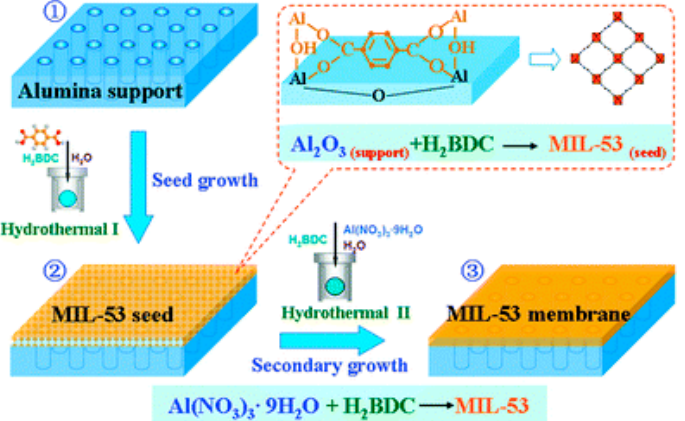
Figure 9. Schematic diagram of preparing the MIL-53 membrane on an alumina support via the reactive seeding method (adapted with permission from ref. [91]).